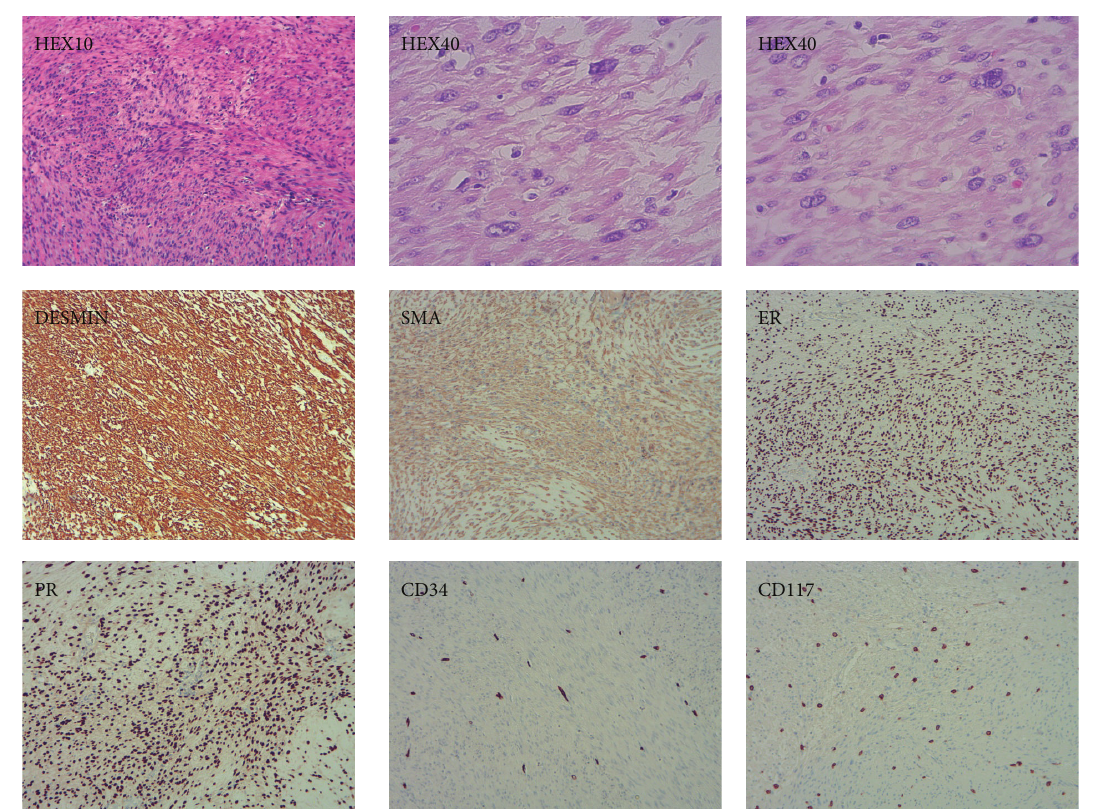
Figure 5: Morphology and Immunohistochemical staining of tumor; HE: hematoxylin-eosin, HEX10 (low power field), HEX40 (high power field), Desmin (positive), SMA: smooth muscle actin (positive), ER: estrogen receptor (positive), PR: progesterone receptor (positive), CD34 (negative), and CD117